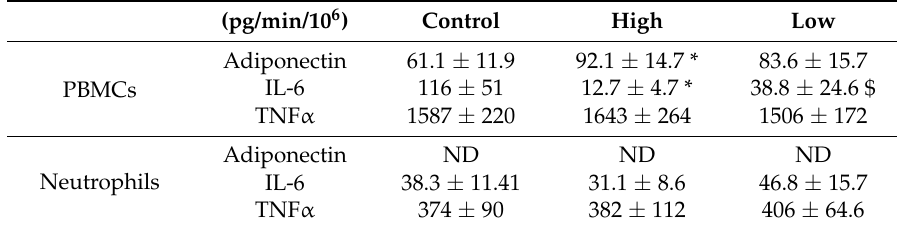
Table 4. Cytokine levels in supernatants of PBMCs and neutrophils samples after 2 h continuous exposure to high and low GOX